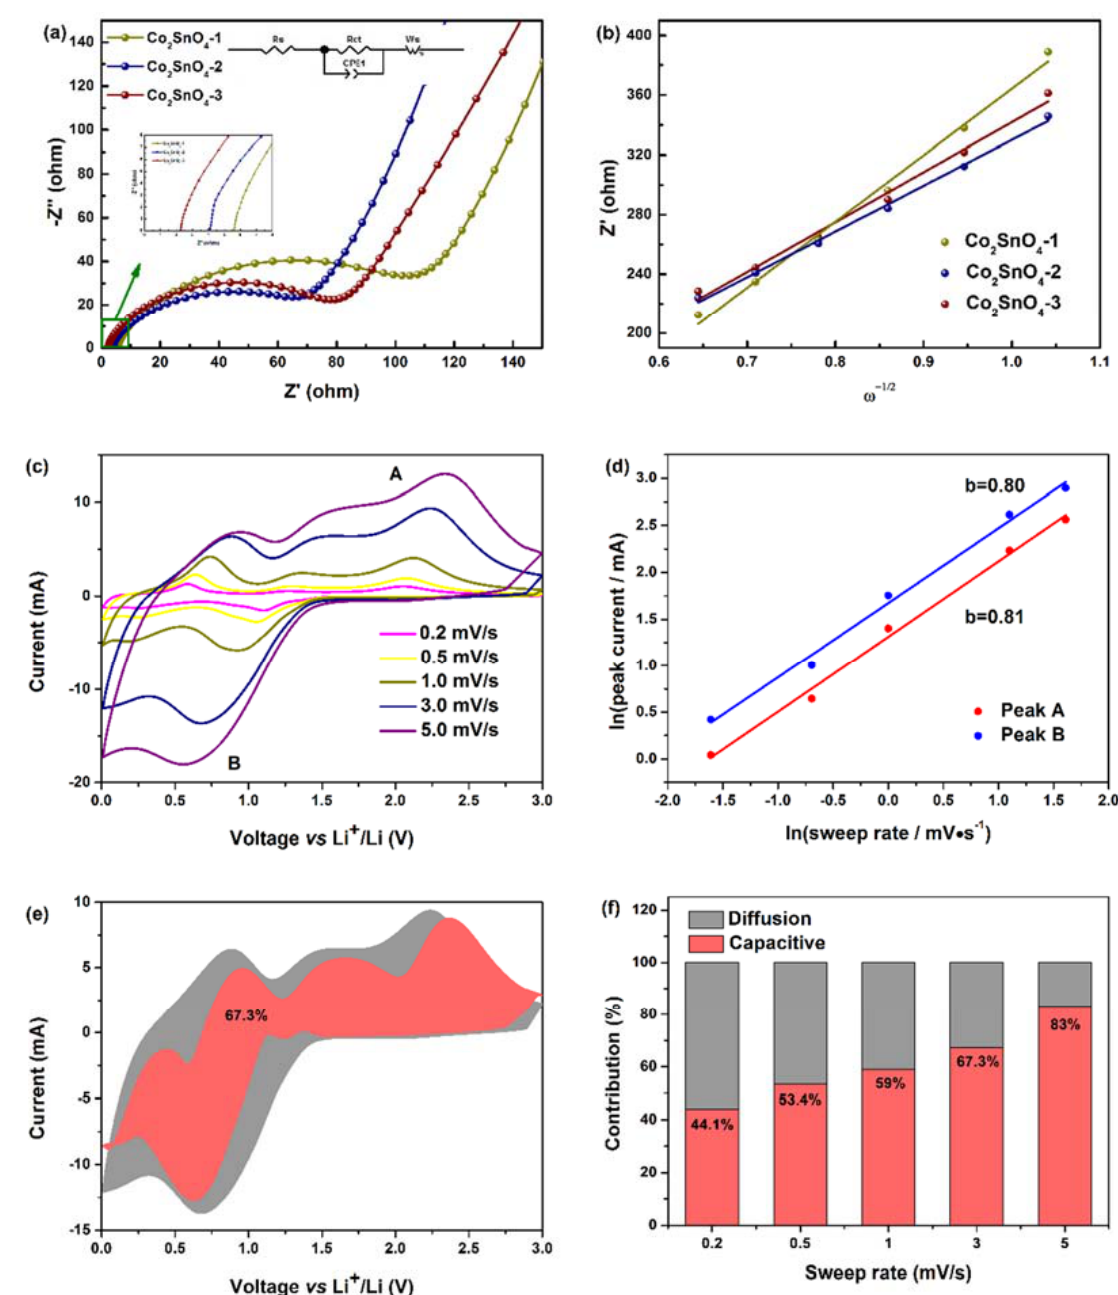
Figure 7. ( a ) Nyquist plots, ( b ) the linear relationship of Z’ and ω − 1/2 of different anodes, respectively. Inset exhibits the equivalent circuit. ( c ) CV curves at various scan rates. ( d ) Relationship between ln( i ) vs. ln( v ). ( e ) Capacitive-contribution at 3.0 mV · s − 1 . ( f ) Contribution ratio of capacitive-controlled capacities at different scan rates for Co 2 SnO 4 -2 anode.